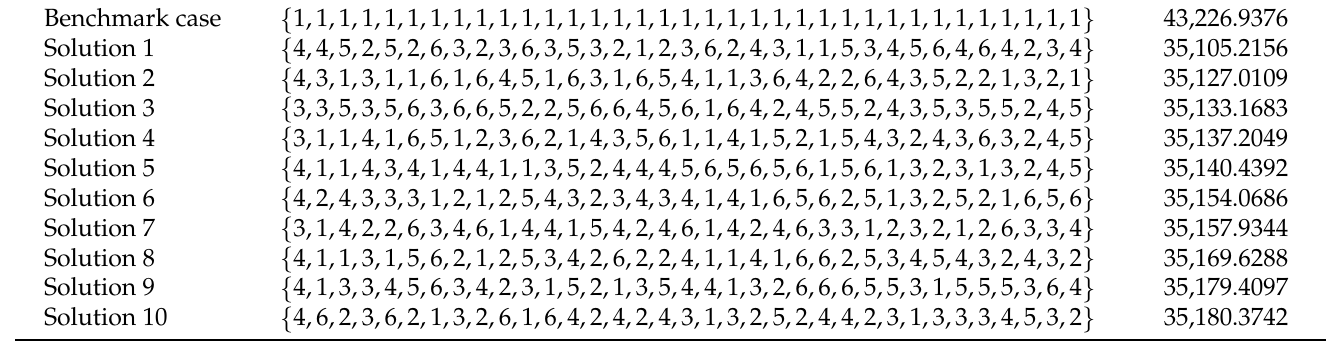
Table 8. Best 10 solutions reported by the improved CBGA for the IEEE 37-bus system. Sol. Number